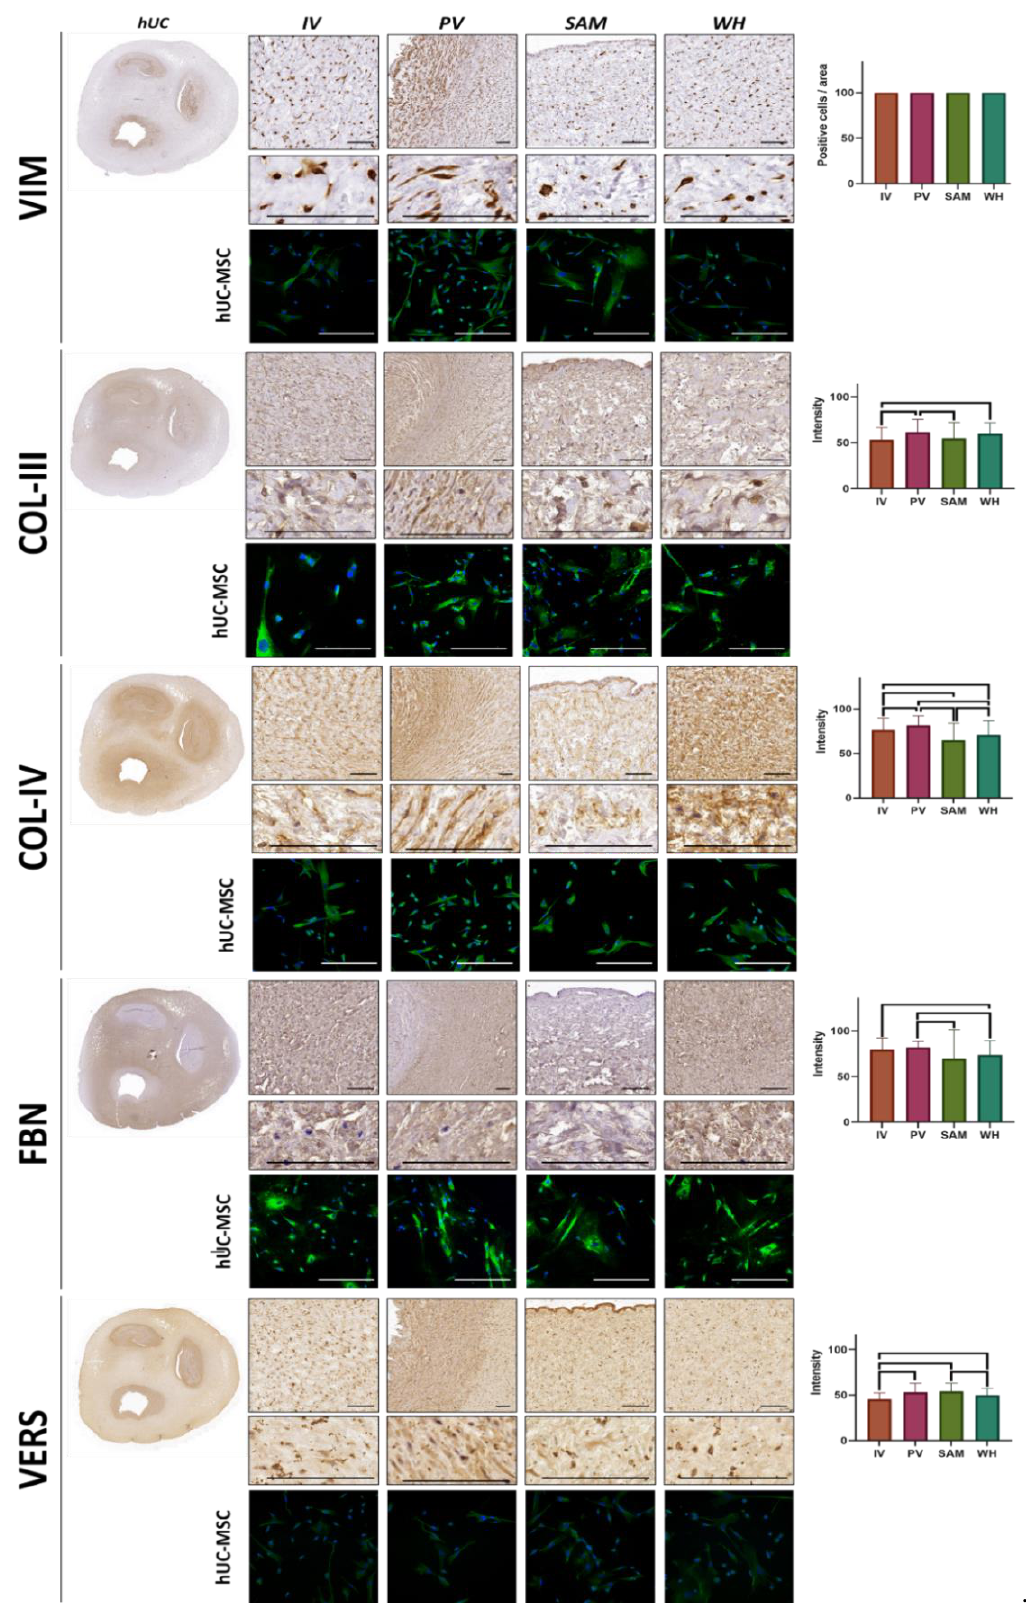
Figure 4. Immunohistochemical analysis of vimentin and four fibrillar (collagen type III — COL-III, and collagen type IV — COL-IV) and non-fibrillar (fibronectin — FBN, and versican — VERS) components of the ECM in the human umbilical cord (hUC) and its different zones. Images obtained at two different magnifications are shown for each marker. Quantification of the percentage of positive cells found in each sample and each method is shown in the histograms to the right, with statistically significant differences shown as brackets. Immunofluorescence images correspond to cells isolated from the hUC and kept in ex vivo culture (hUC-MSC), with positive signals shown in green, and cell nuclei shown in blue. IV: intervascular zone; PV: perivascular zone; SAM: subamnioblastic zone; WH: Wharton zone. Scale bar = 200 µm.